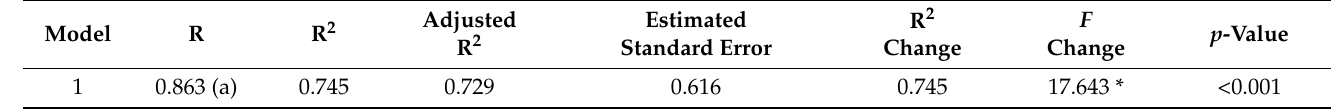
Table 7. Summary of the step volumes of the EGa for multiple regression model 1.